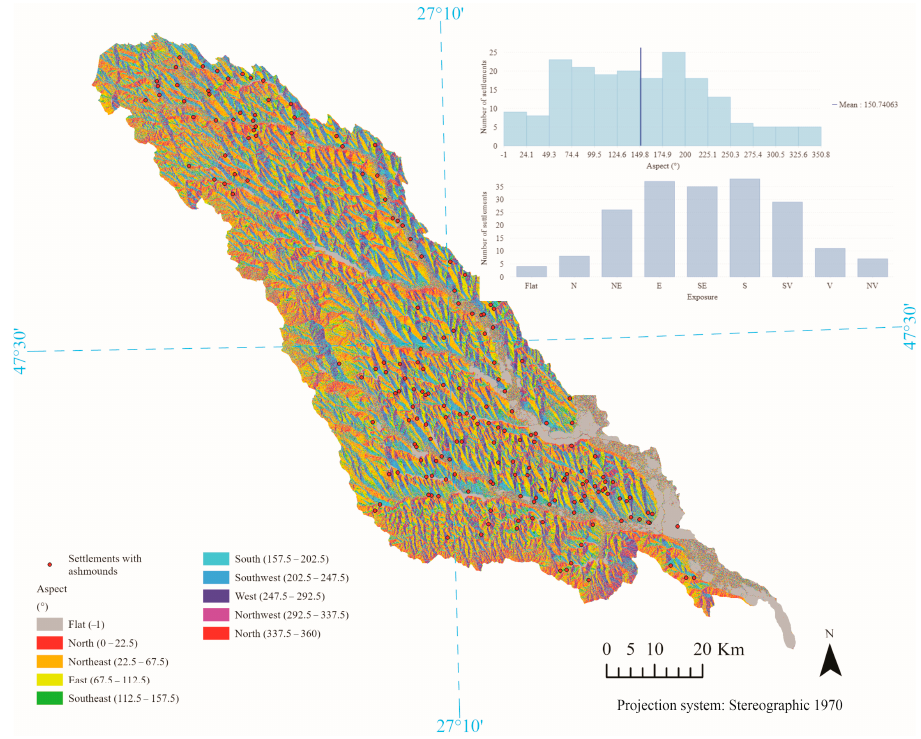
Figure 7. Noua settlements with ashmounds overlapped on Aspect map, with graphs showing the exposure values of all the sites and their distribution within the main categories.